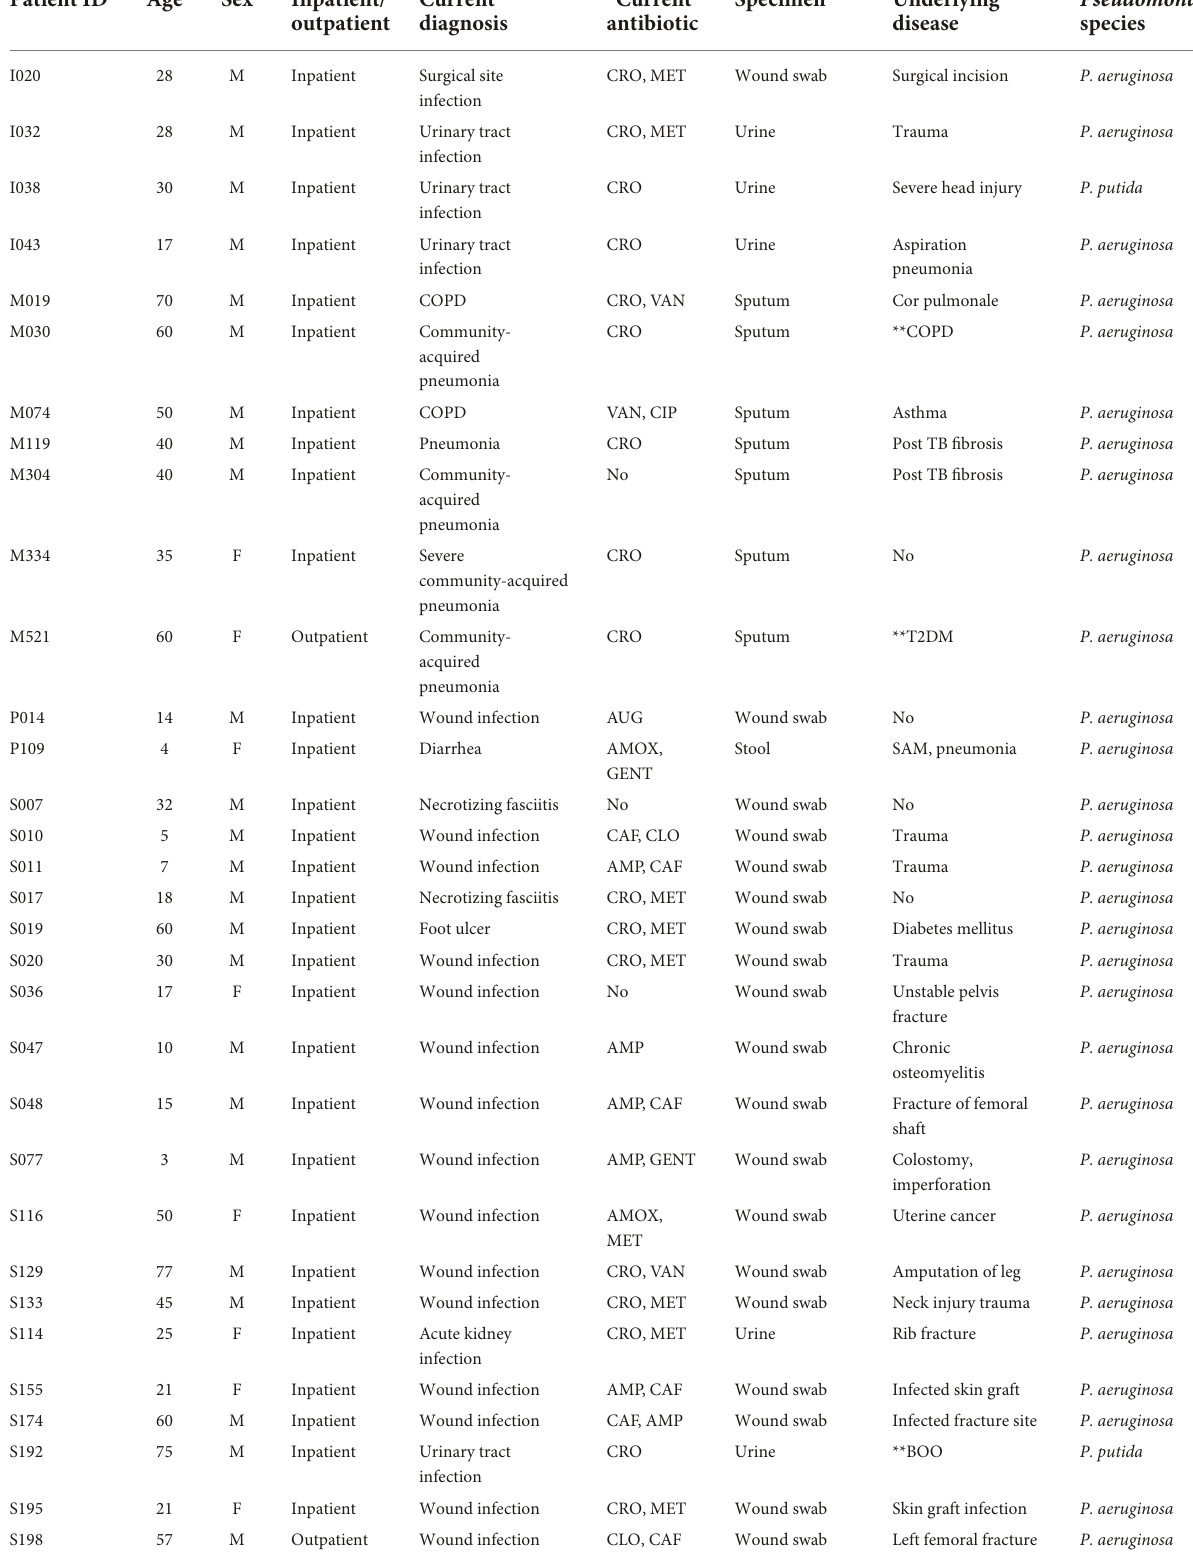
TABLE 1A Socio-demographic and clinical characteristics patients and isolation Pseudomonas species. Patient ID Age Inpatient/